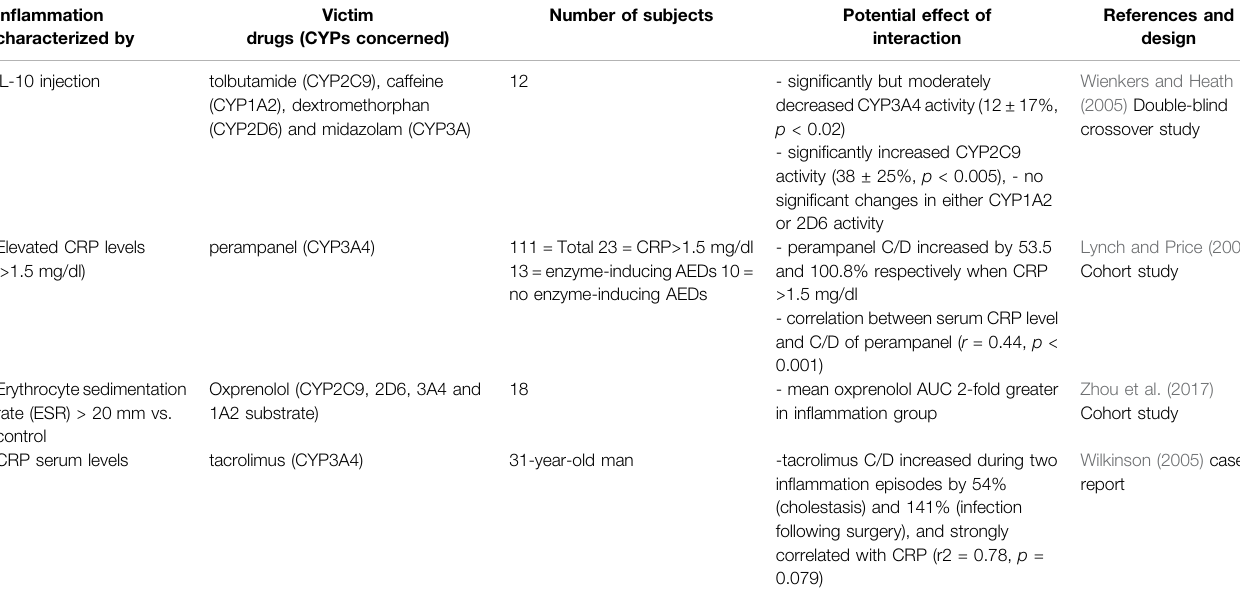
TABLE 1 | Impact of unspeci fi ed source in fl ammation on CYP substrates, explained totally or partially by modulation of CYP